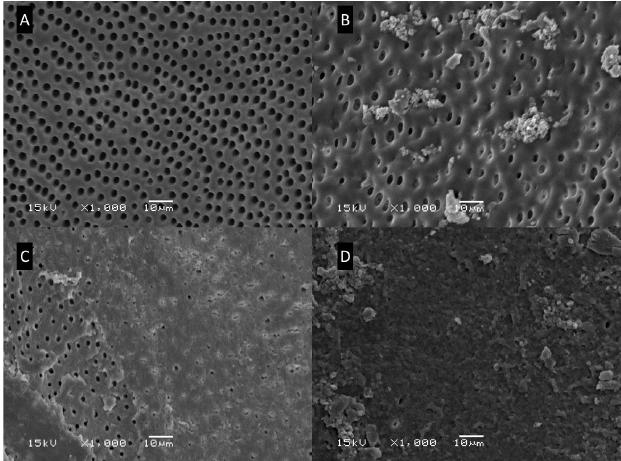
Fig.1. Photomicrographs by SEM of the scoring system used to analyze the effectiveness of each group in smear layer removal. (A) Score 1; (B) Score 2; (C) Score 3; (D) Score 4.